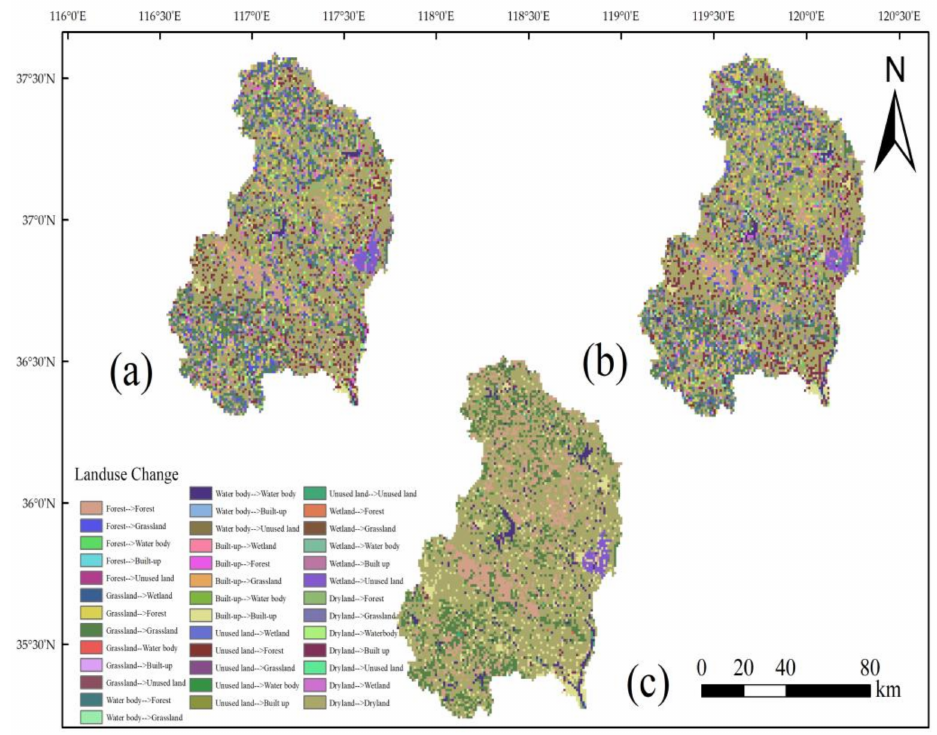
Figure 9. Land-use transfer from 1990 to 1995 ( a ); land-use transfer from 1995 to 2005 ( b ); land-use transfer from 2005 to 2015 ( c